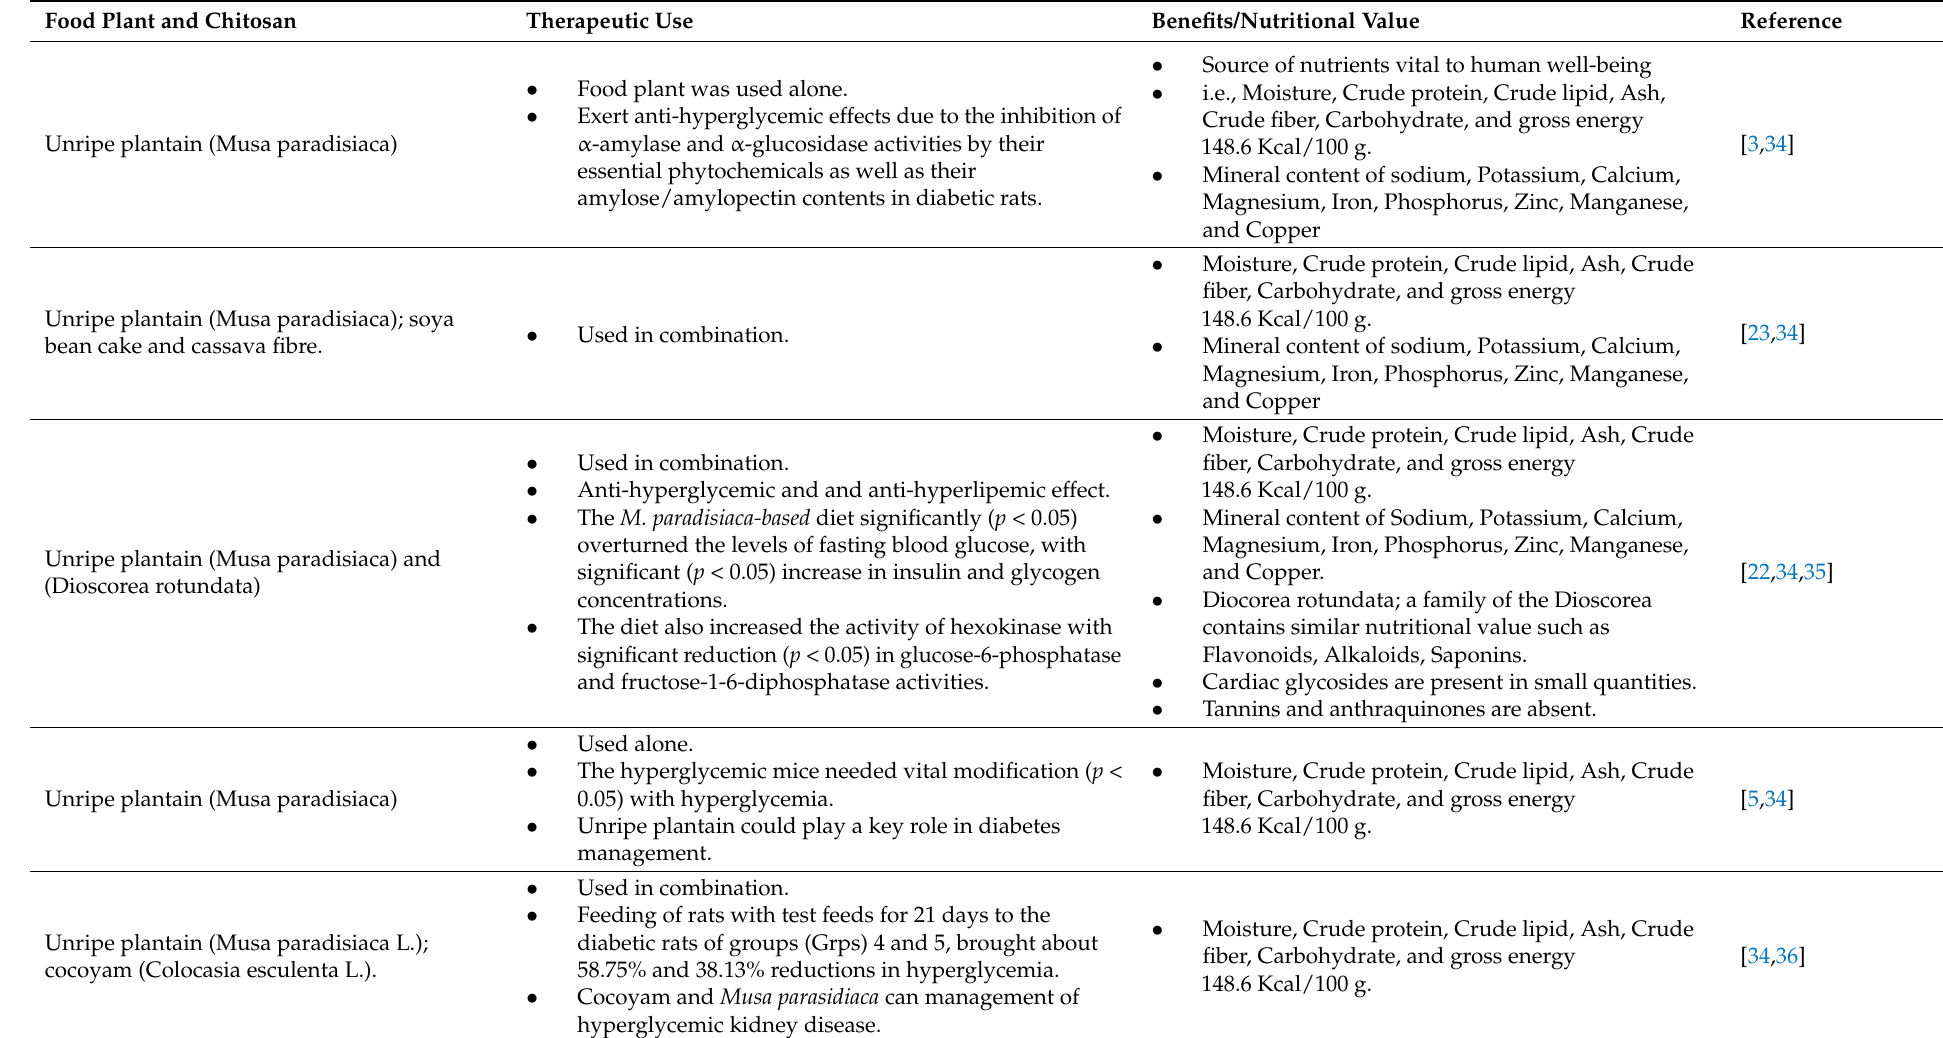
Table 2. Food plants and chitosan used for their therapeutic and benefit in T2D. Food Plant and